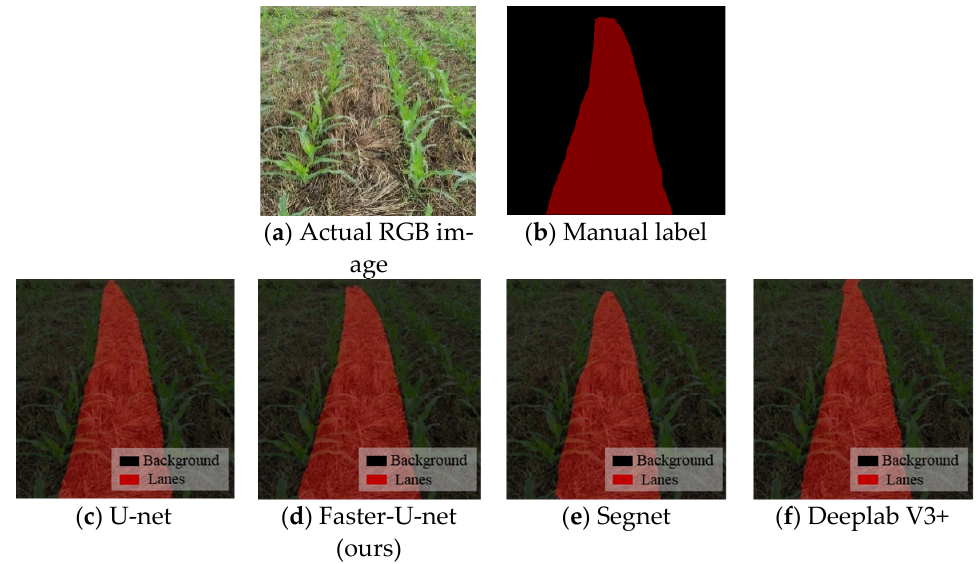
Figure 11. Prediction results of corn navigation path. ( a ) Actual RGB image was collected in the field. ( b ) Manual label gave path semantic information. ( c ) The path result as predicted by the U-net network. ( d ) The path result as predicted by the Faster-U-net network. ( e ) The path result as predicted by the Segnet network. ( f ) The path result as predicted by the Deeplab V3+